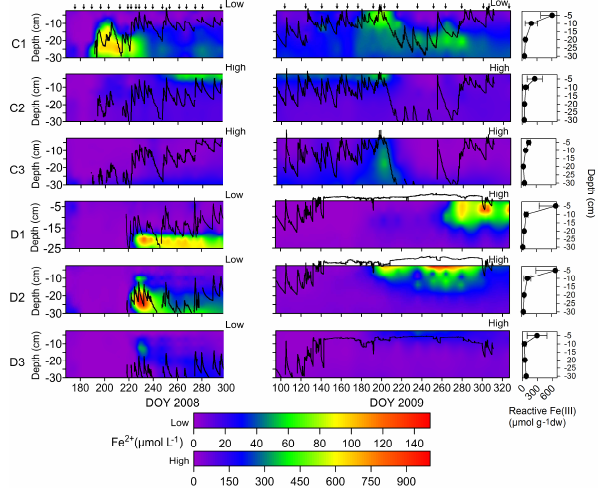
Fig. 6. Dissolved ferrous (Fe 2 + ) concentrations. Refer to caption in Fig. 2. Note the different scales. During flooding up to 2mmolL − 1 were detected in D2 (not shown for clarity). The depth distribution of reactive ferric iron content in the solid phase is shown to em- phasise the differences among plots, but it was not measured in this study (Table 1). Figure 7